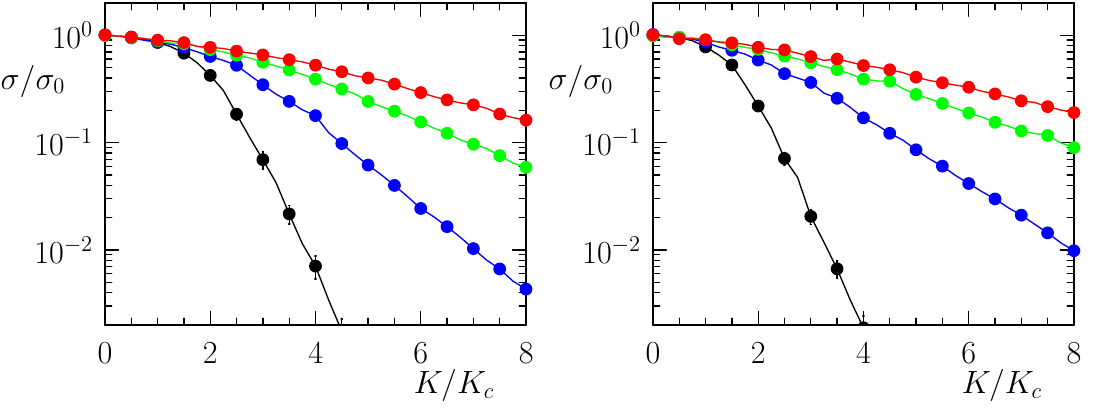
Figure A1. Dependence of the rescaled conductivity of the atom chain σ / σ 0 on the rescaled potential amplitude K / K c at different rescaled temperatures T / K c . Left panel: T / K c = 0.25 (black curve), 1 (blue curve), 2 (green curve), 3 (red curve), curves from bottom to top, ν = 34/21 Right panel: same values of T / K c with the same order of curves, ν = 55/21 σ 0 = ν / ( 2 πη )